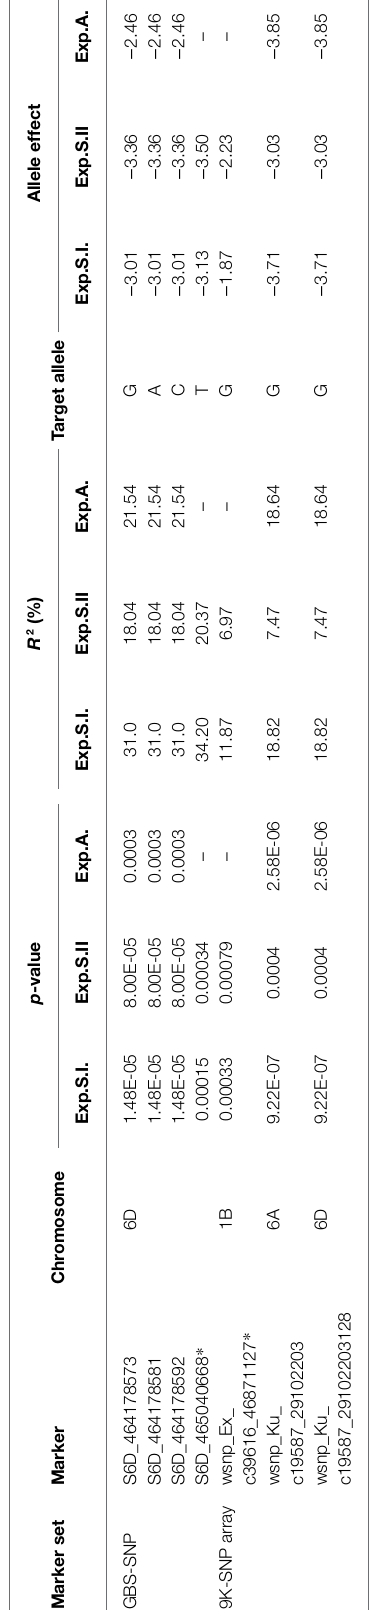
different regions. The LD between each pair of the significant markers is presented in detail in Supplementary Table S7 .